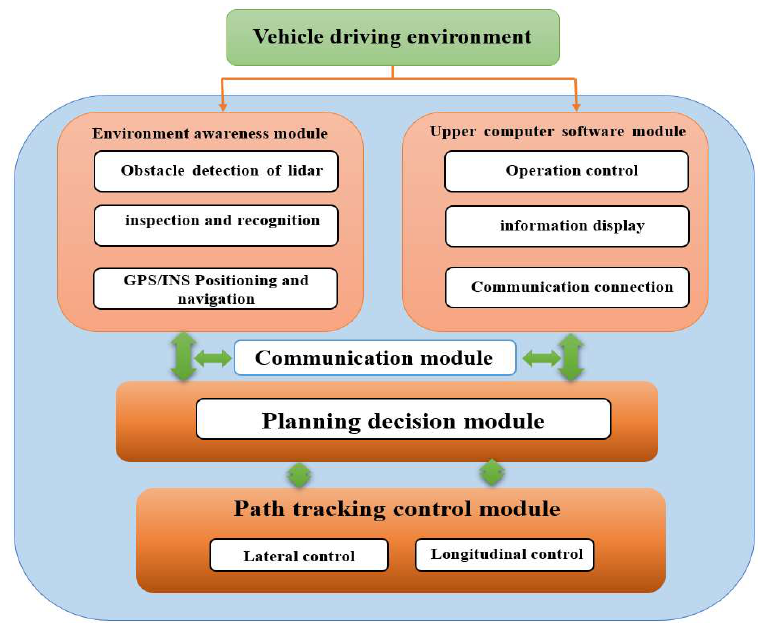
Figure 10. Functional module design of test platform.